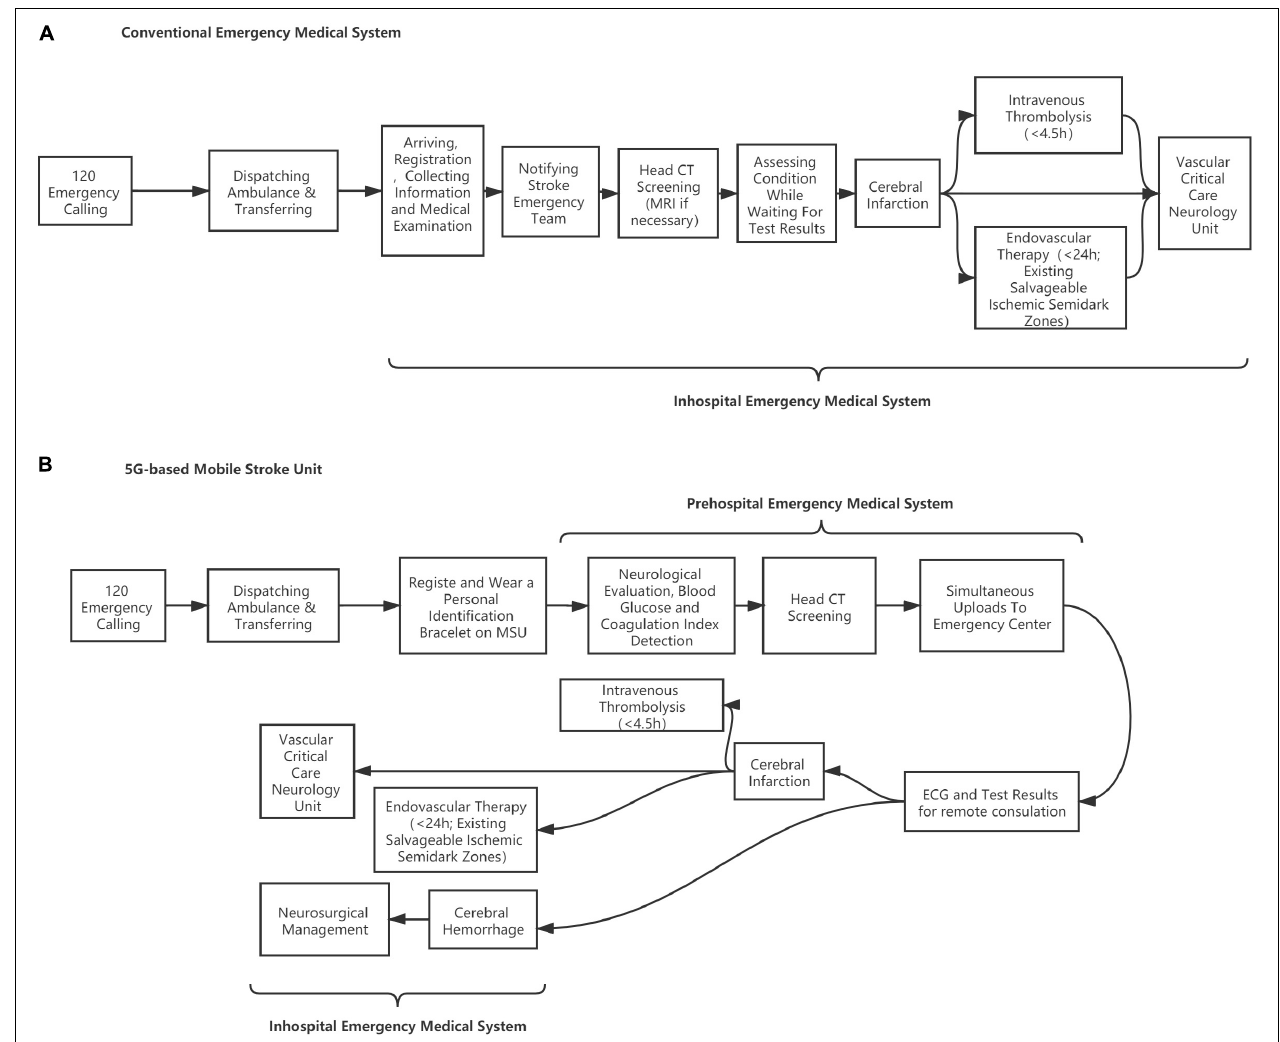
FIGURE 1 | Flow diagram of patients screening. (A) Conventional emergency medical system. (B) 5G-based mobile stroke